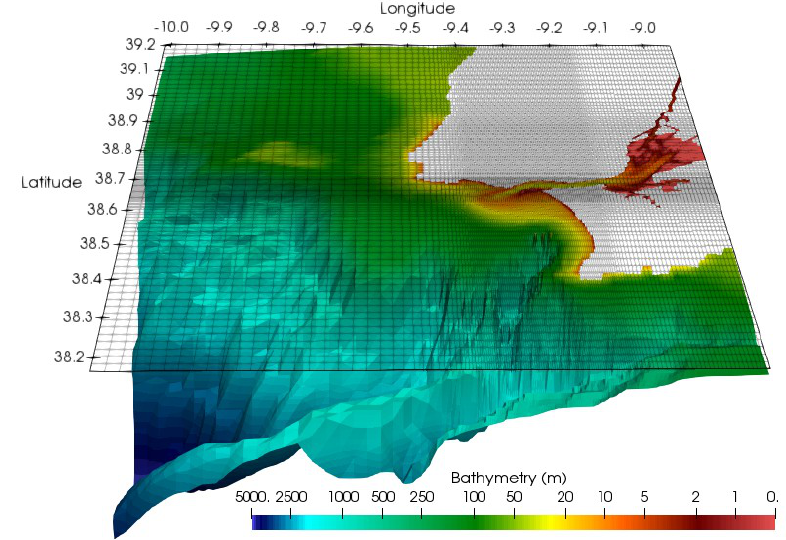
Figure 2. TagusROFI domain bathymetry. Colours represent the depth in meters (m) and land in grey. The colour scale is logarithmic.